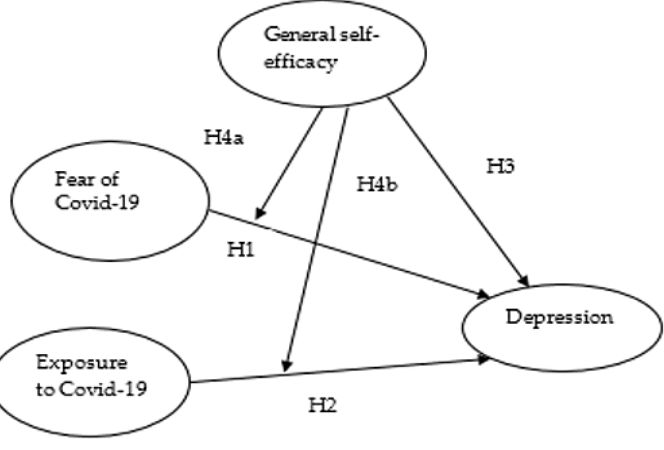
Figure 1. Proposed model of study .